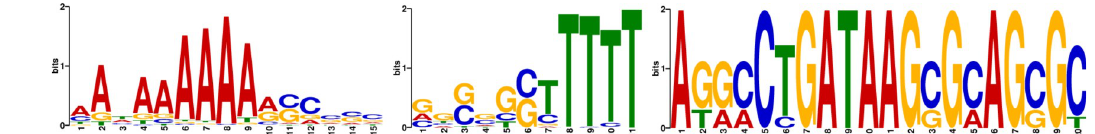
Fig 10. Motif diagram of the terminator sequence. The figure shows three motif diagrams we discovered of terminator sequences.